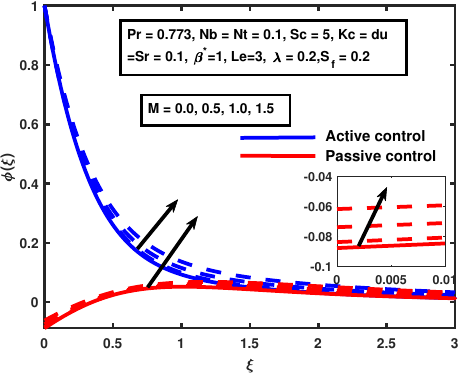
Figure 15. The impact of φ ( ξ ) on magnetic M .